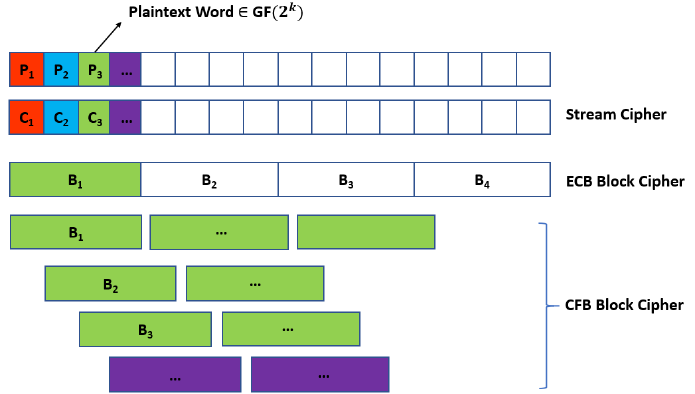
Figure 10. Diffusion for each mode of cryptosystem.